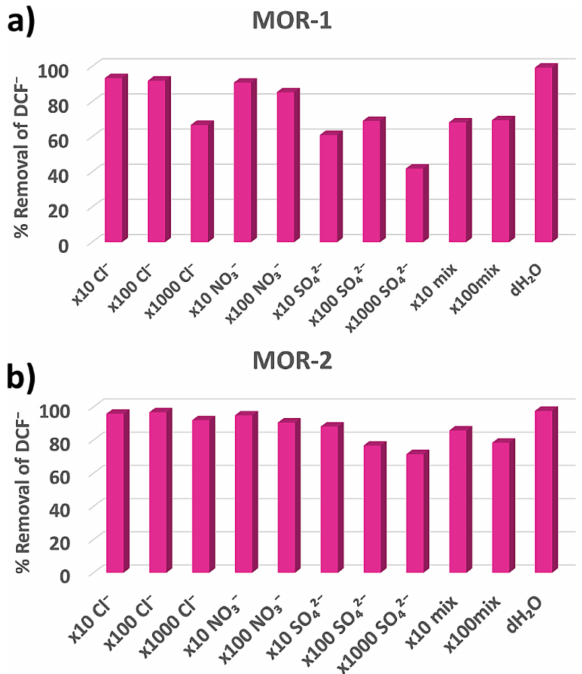
Figure 4. DCF − sorption data for ( a ) MOR-1 and ( b ) MOR-2 in the presence of various competitive